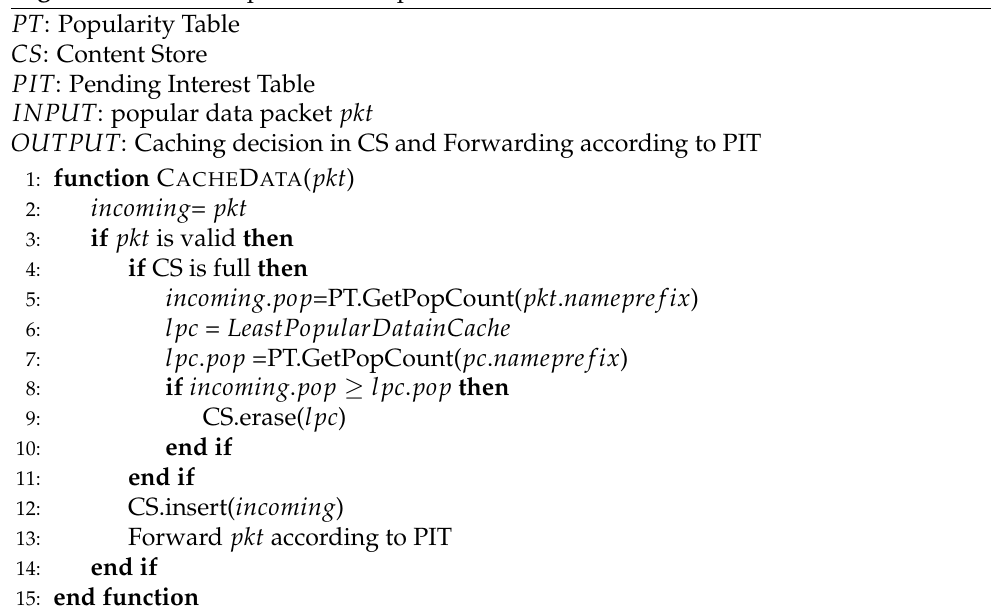
Algorithm 1 Least Popular First Replacement